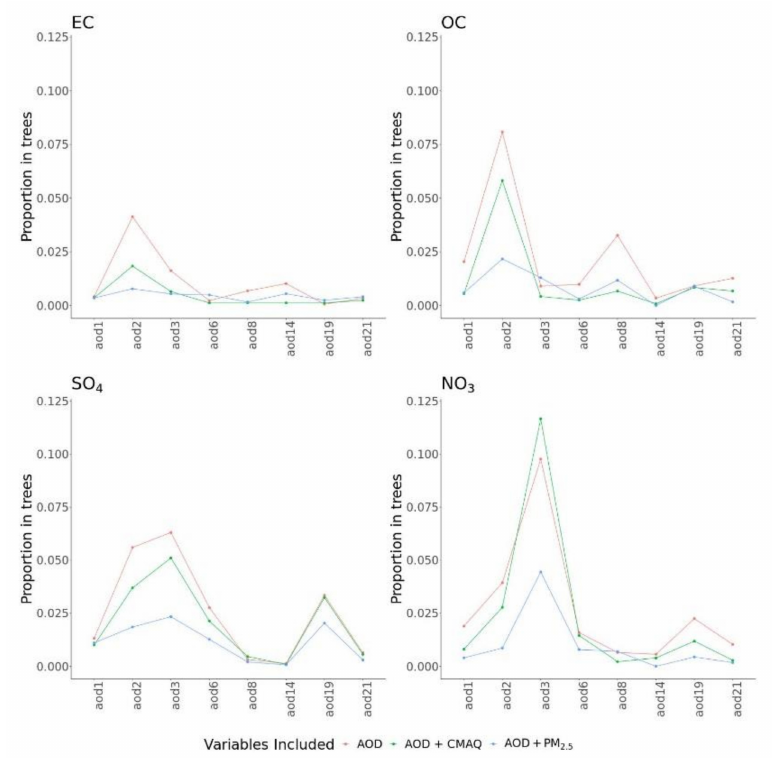
Figure 2. BART variable importance (proportion in trees) of individual AOD fractional components for predicting PM 2.5 components elemental carbon (EC), organic carbon (OC), sulfate (SO 4 ), and nitrate (NO 3 ), under di ff erent predictor sets (with MISR fractional AOD, with AOD and CMAQ simulations, or with AOD and PM 2.5 total mass). All models include meteorology and land-use